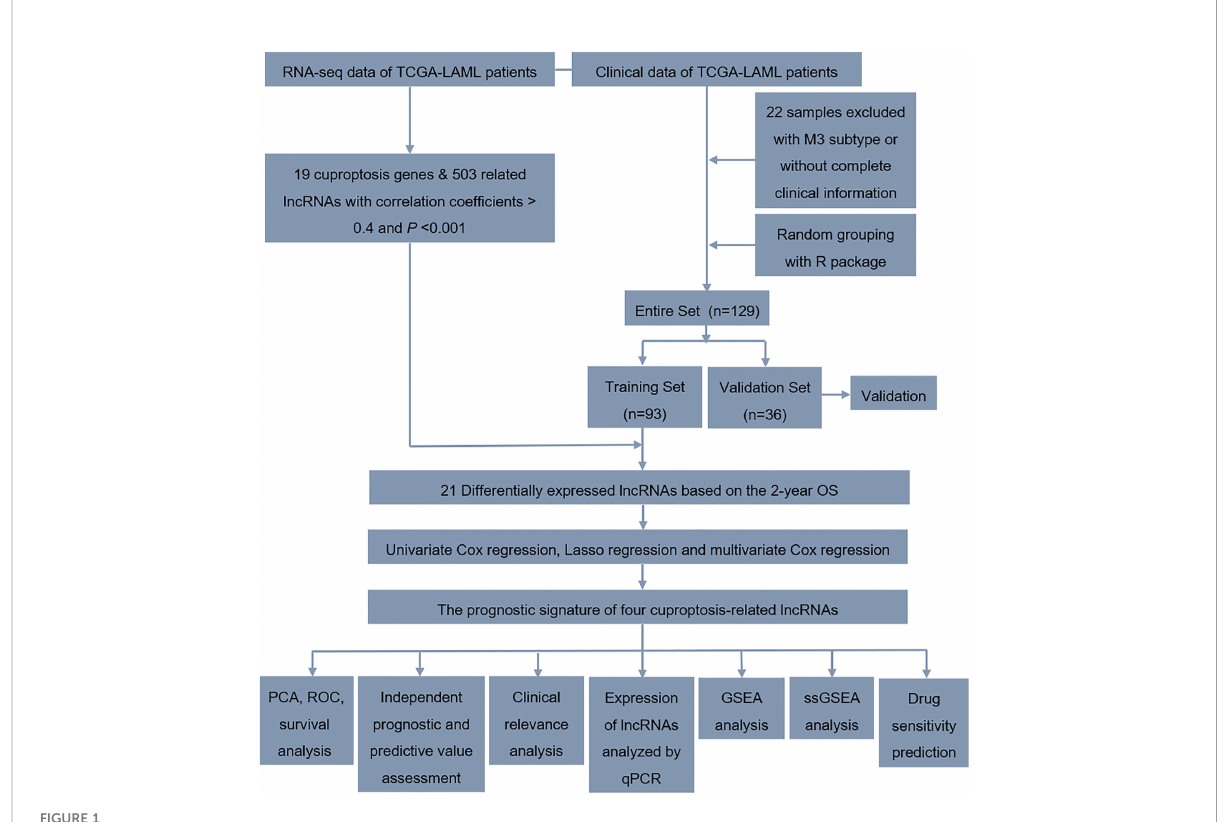
FIGURE 1 Work fl ow of the study